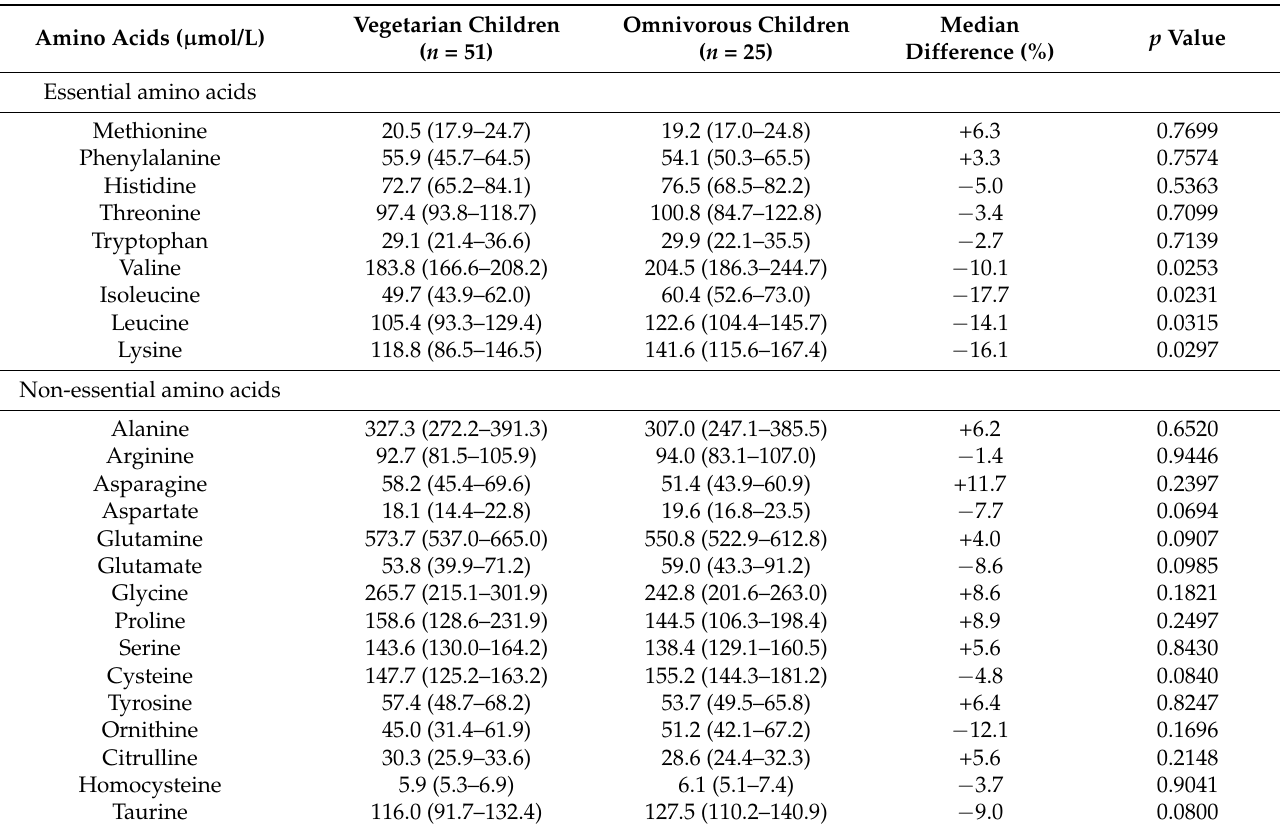
Table 3. Concentrations of amino acids in the serum of children on vegetarian and omnivorous